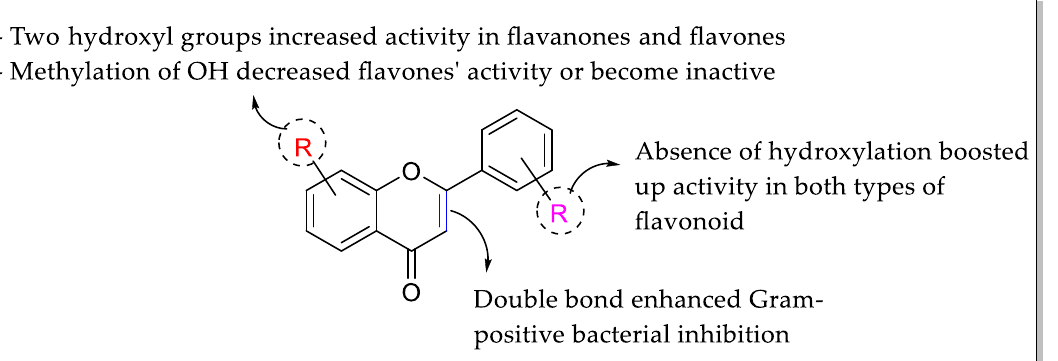
Figure 9. Chemical structure of several tested flavonoids and the SAR of flavonoids studied for antibacterial properties against four Gram-positive and four Gram-negative bacteria [76].